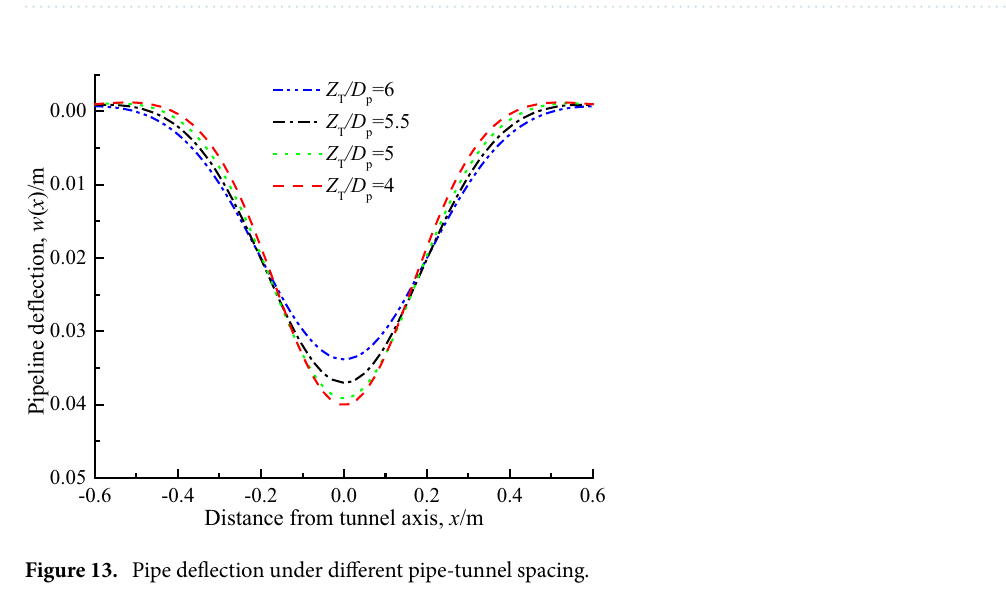
Figure 12. Pipe deflection under different soil modulus.